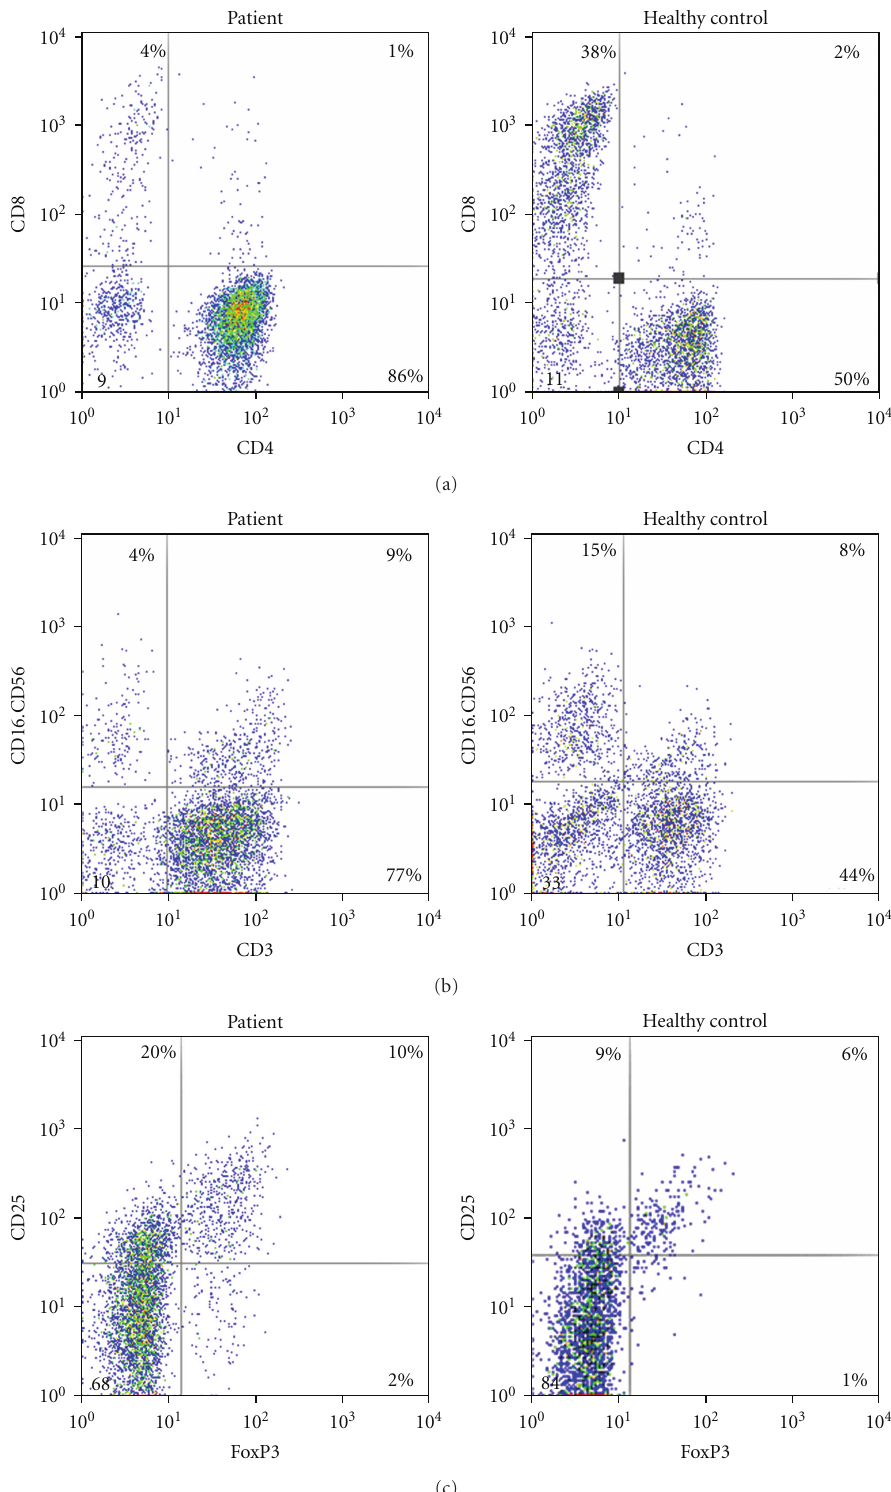
Figure 1: Flow cytometry results from a series of representative patients and healthy controls. (a) The cells in the upper left quadrant and the lower right of the dot plot are CD3 + CD8 + T and CD3 + CD4 + T cells, respectively. (b) The cells in the upper left quadrant are NK cells. (c) The cells in the upper right quadrant of the dot plot are CD4 + CD25 + Foxp3 +